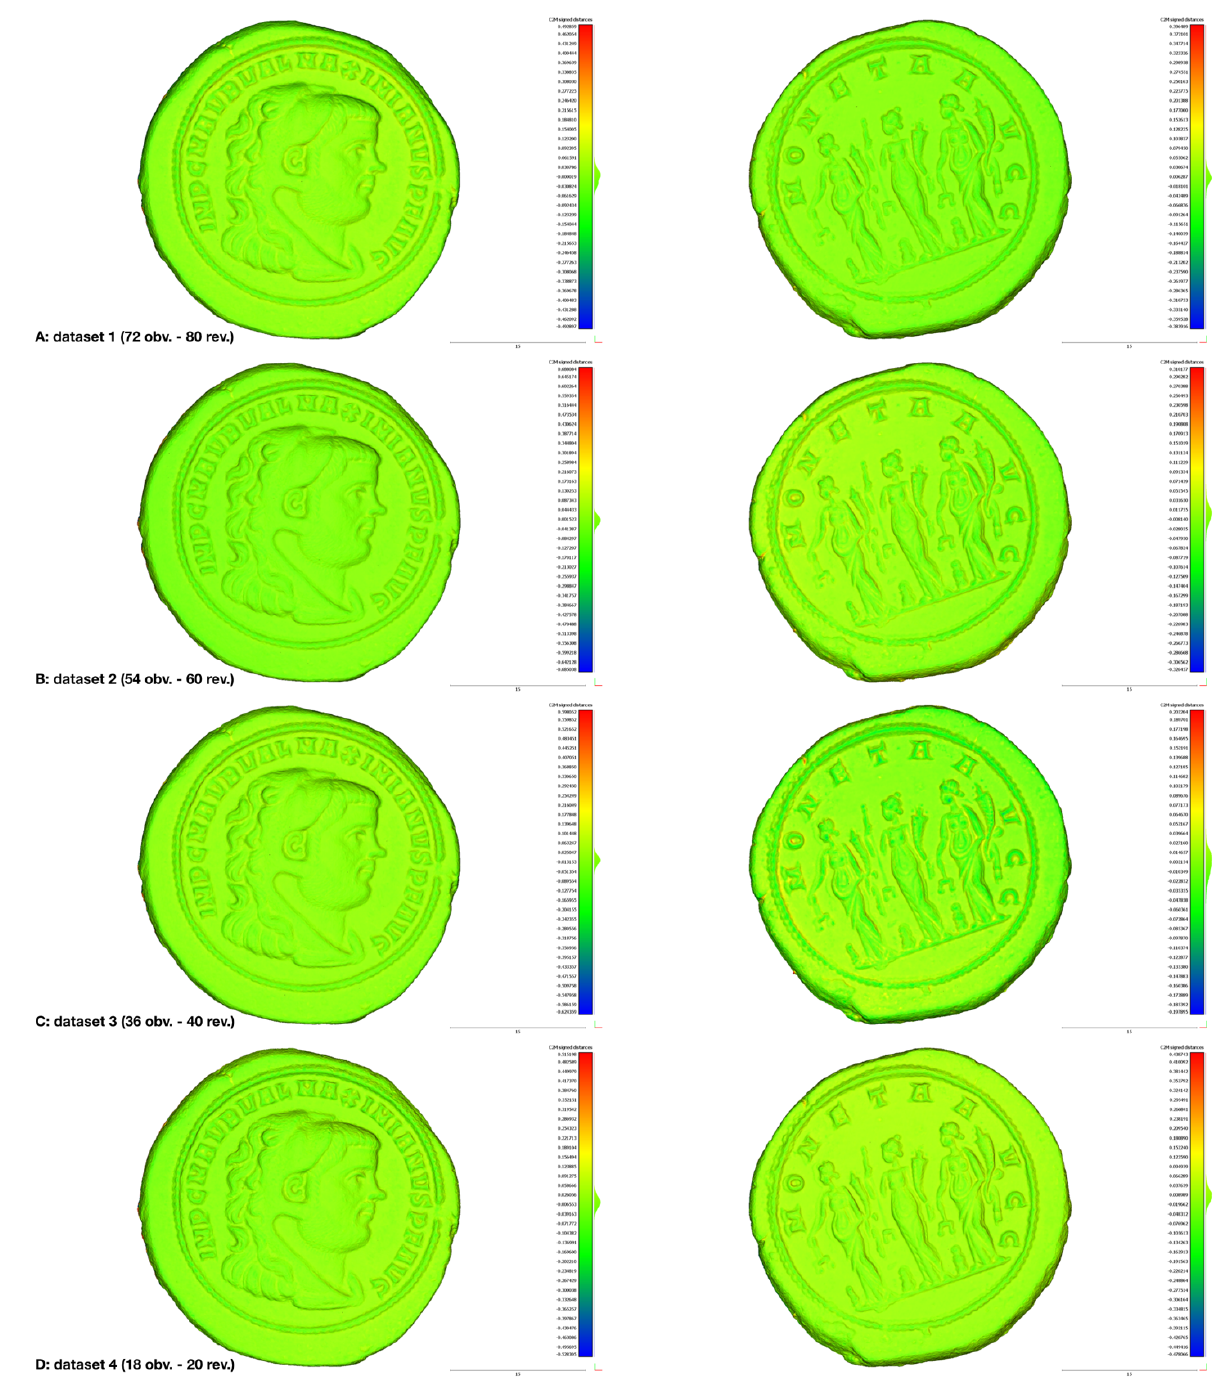
Figure 2. Distance analysis, processed with the software Cloud Compare, was calculated between the two sides of the medallion recorded with photogrammetry and the other two sides of the medallion acquired with the scanner (Aurum 3D). On the right of each mesh a scale bar indicates the distance values (cool colours = negative values of distance; warm colours = positive values of distance; light green colour = zero